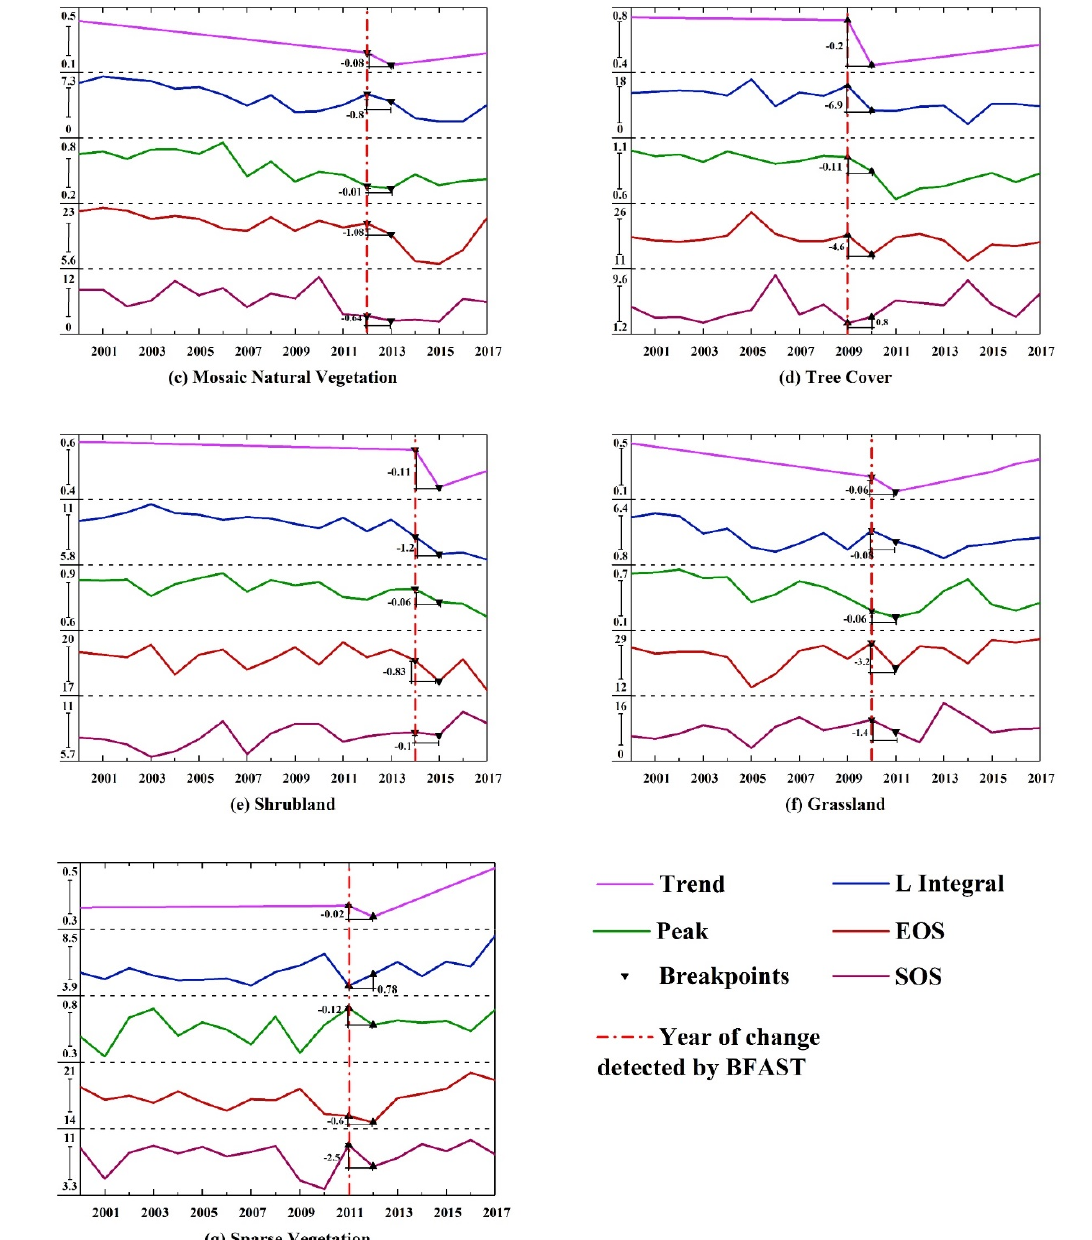
Figure 10. The trajectory changes of the trend component and the sensitive phenological indicators extracted by TIMESAT. ( a ) trajectory changes of cropland, ( b ) trajectory changes of herbaceous, ( c ) trajectory changes of mosaic natural vegetation, ( d ) trajectory changes of tree cover, ( e ) trajectory changes of shrubland, ( f ) trajectory changes of grassland, and ( g ) trajectory changes of sparse vegetation.